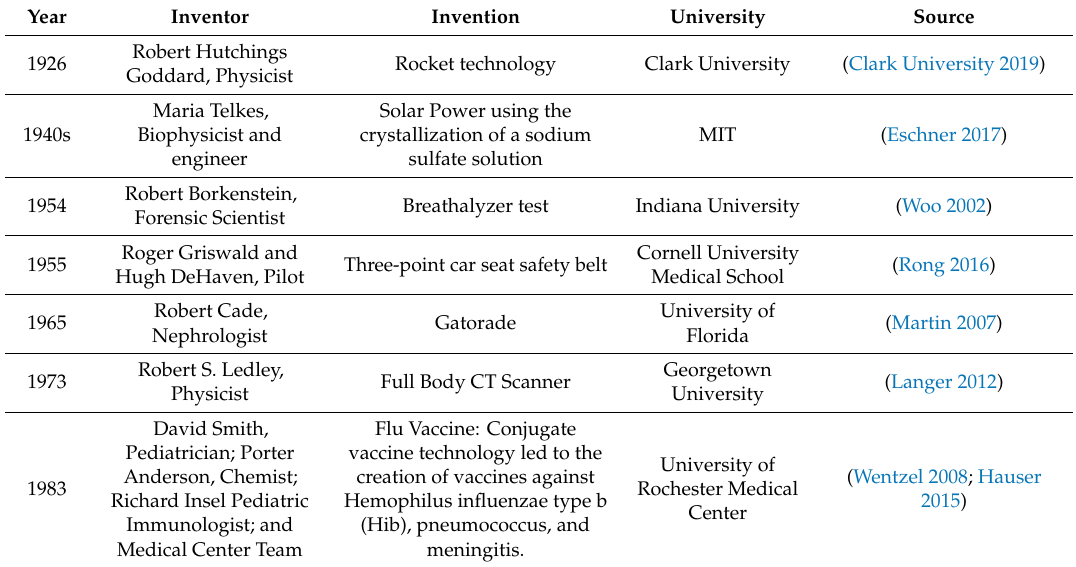
Table 1. Examples of significant inventions / technologies originating at